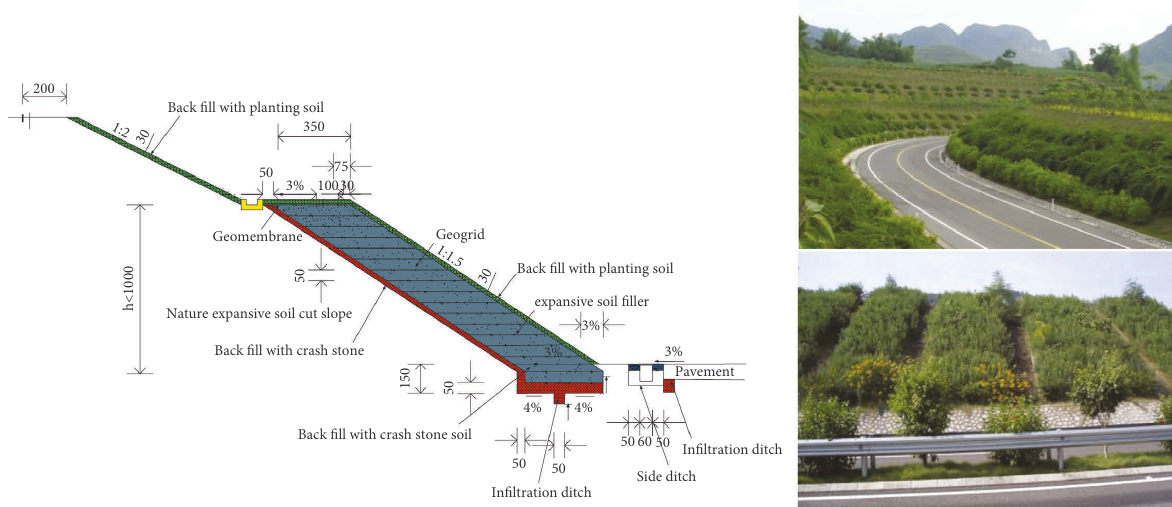
Figure 14: Design drawing of the flexible support structure and treatment effect.